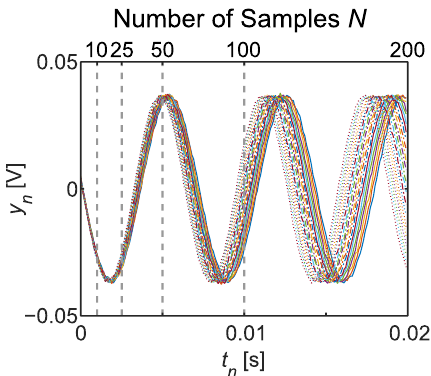
Figure 4. Output voltage samples simulated from a stepper motor excited by 21 sinewaves with frequencies evenly spaced from 140 to 160 Hz. Vertical dashed lines denote the total durations of subsets with various numbers of samples N . (See legend in Figure 5 for the ground truth frequency corresponding to each combination of color and line style.)